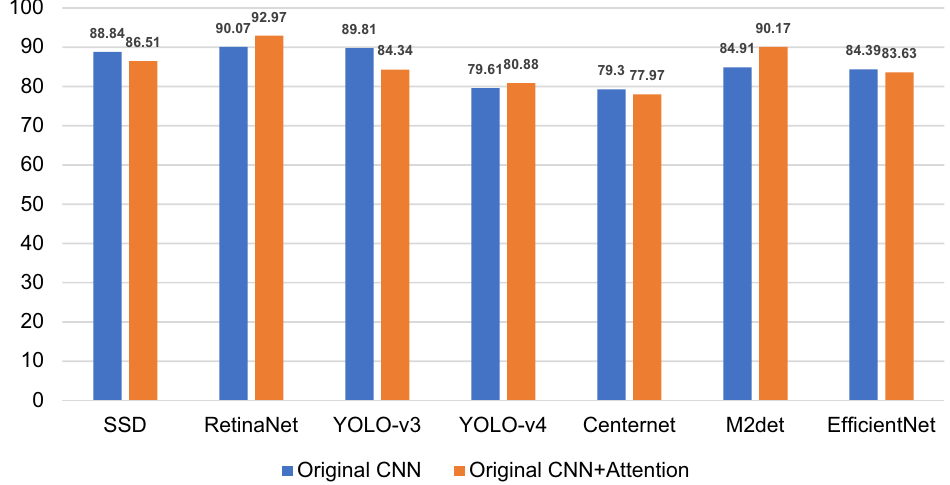
Figure 14. mAP values of different CNNs with or without channel Attention